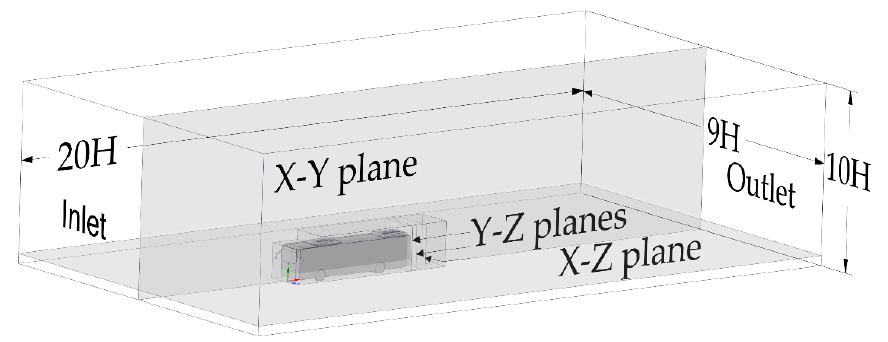
Figure 3. Flow domain of the bus.